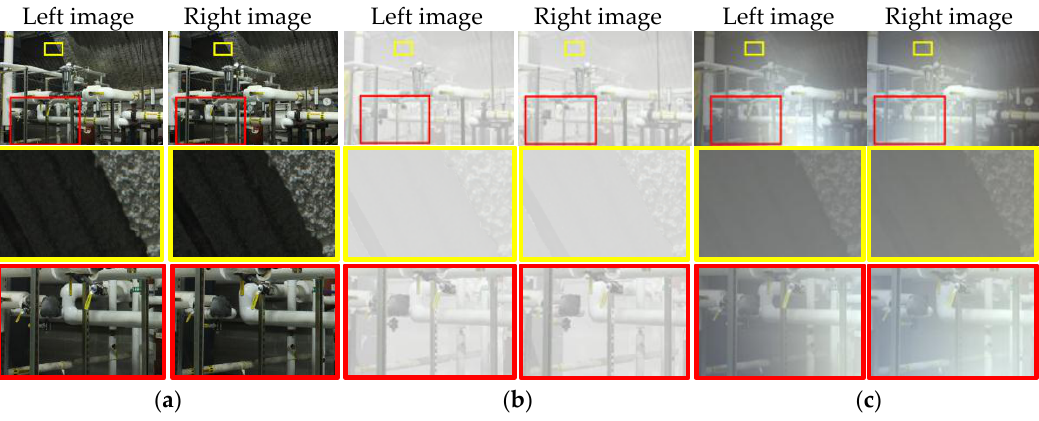
Figure 2. Example of stereo images (pipes from the Middlebury 2014 stereo datasets [9]) in different environment: ( a ) Stereo pair taken in clean environment; ( b ) Stereo pair taken in foggy environment with natural light source that suffers from attenuation uniform scattering; ( c ) Stereo pair taken in dense scatterer environment under an active light source that suffers both attenuation and non-uniform backscattering.